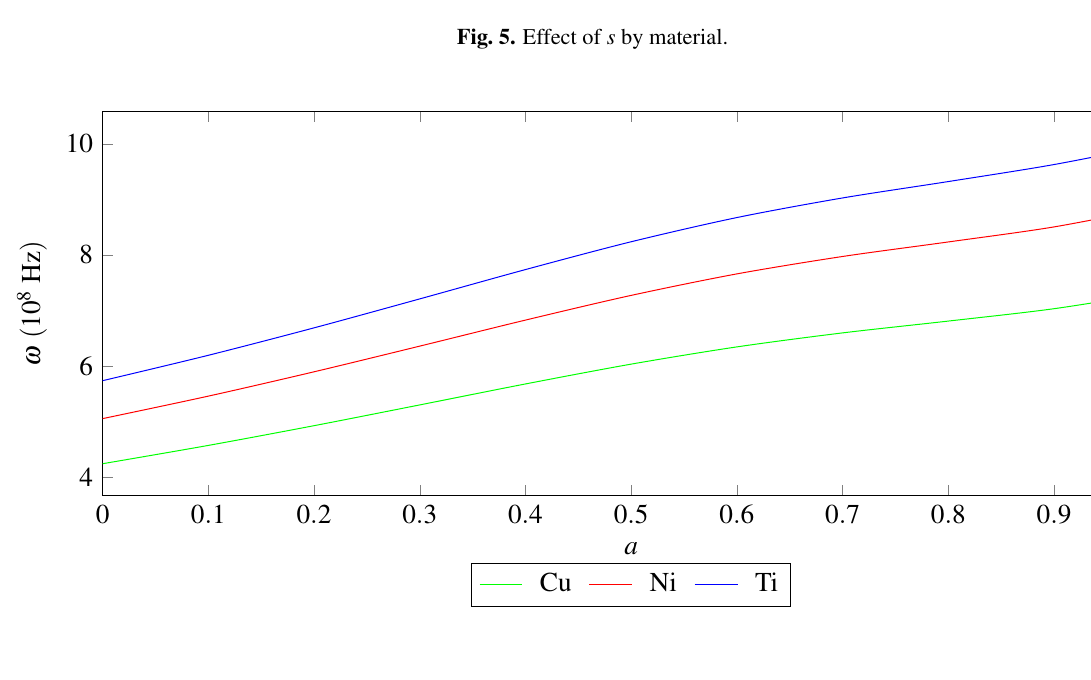
Fig. 6. Effect of a by